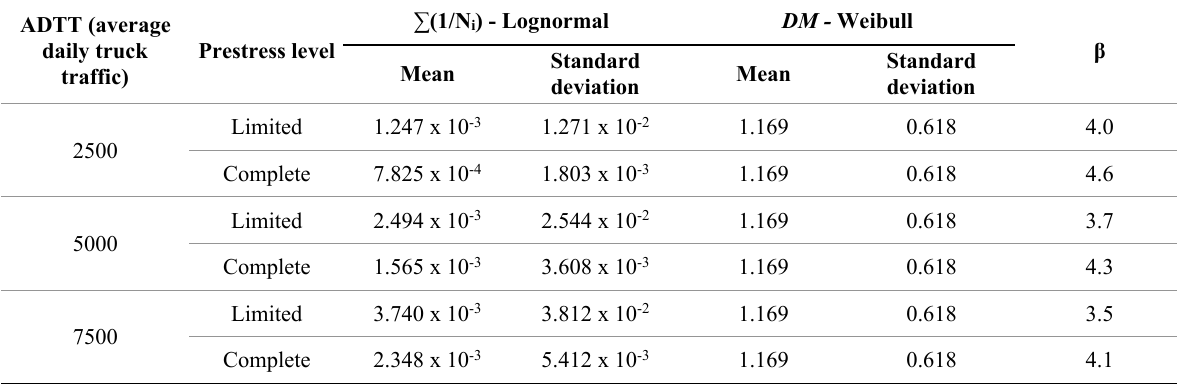
Table 8. Momen ts for dependent variables and reliability indexes (β) for reinforcing steel (exterior girder) for design service life of 50 years.